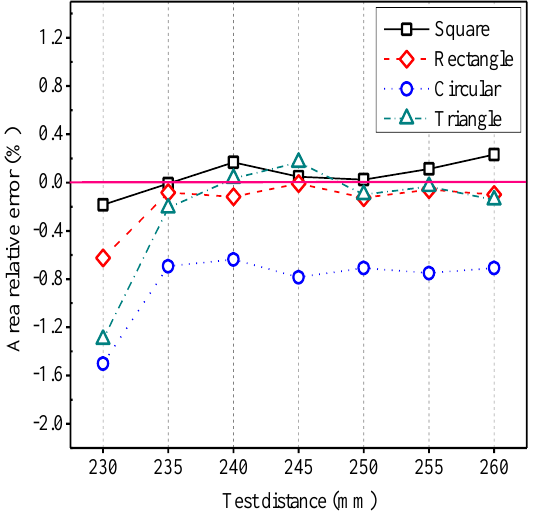
Figure 7. The relationship between the test distance and area relative error for different leaf shape patterns.